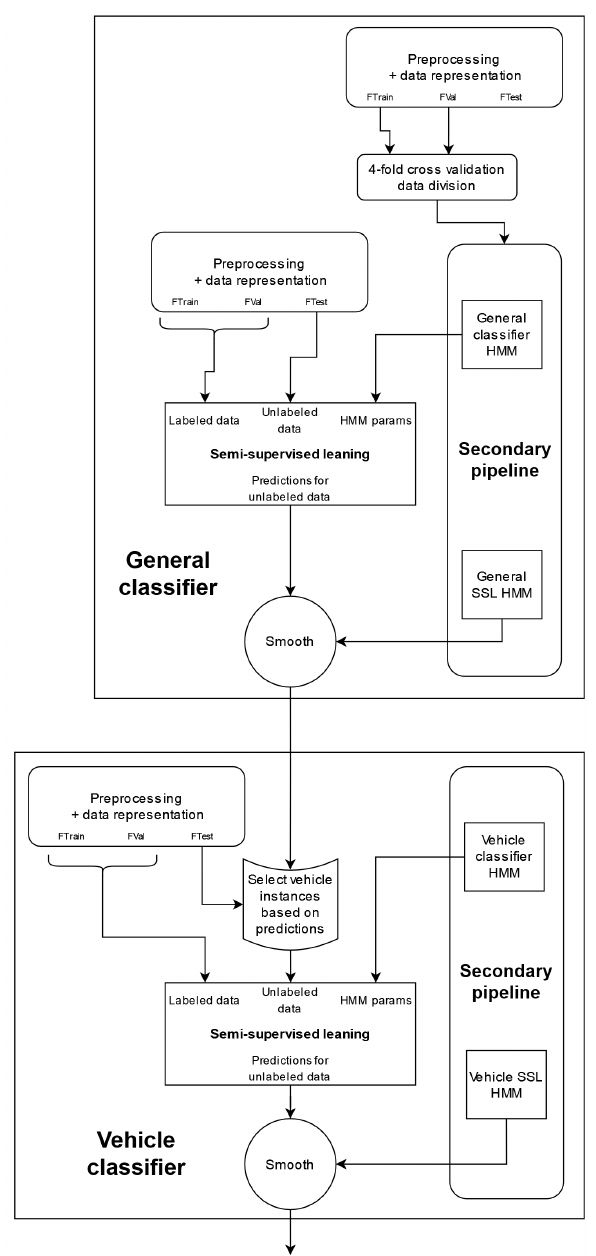
Figure 4. A diagram of the main classification pipeline used for the data from 2019.